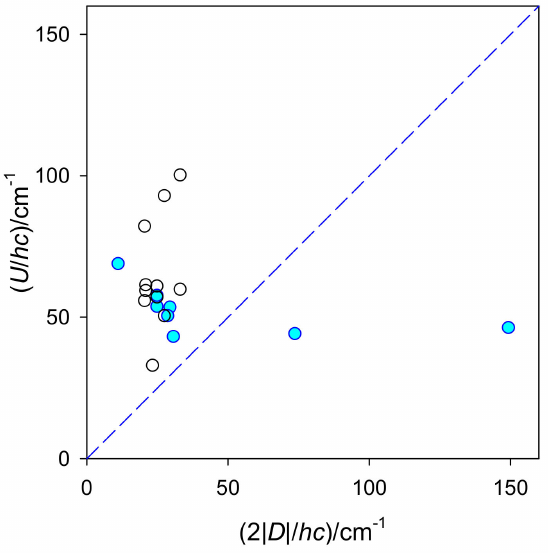
Figure 6. Collection of relaxation data for tetracoordinate Co(II) complexes, S = 3/2. Full points for D < 0, empty for D > 0. Dashed line—a hypothetical D - U paradigm. (1/ k B ) = 1.439 K/cm − 1